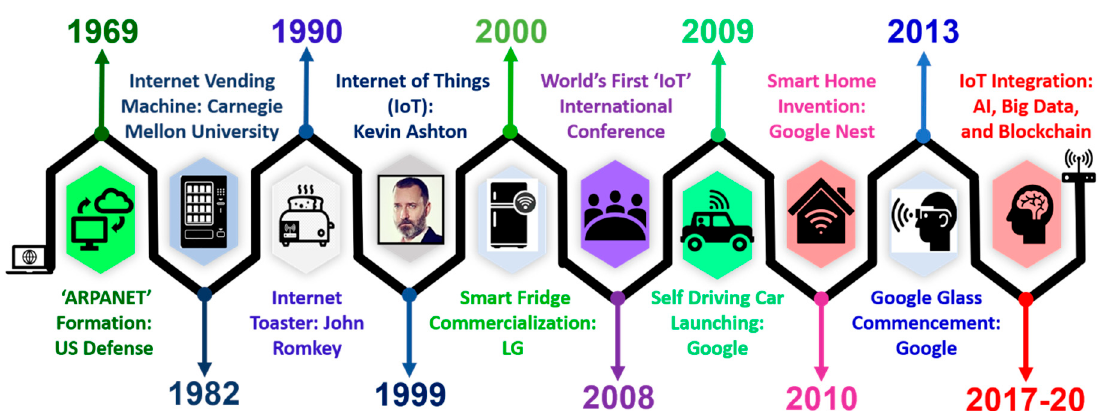
Figure 1. Internet of things (IoT) timeline in infographics (1969–2020).